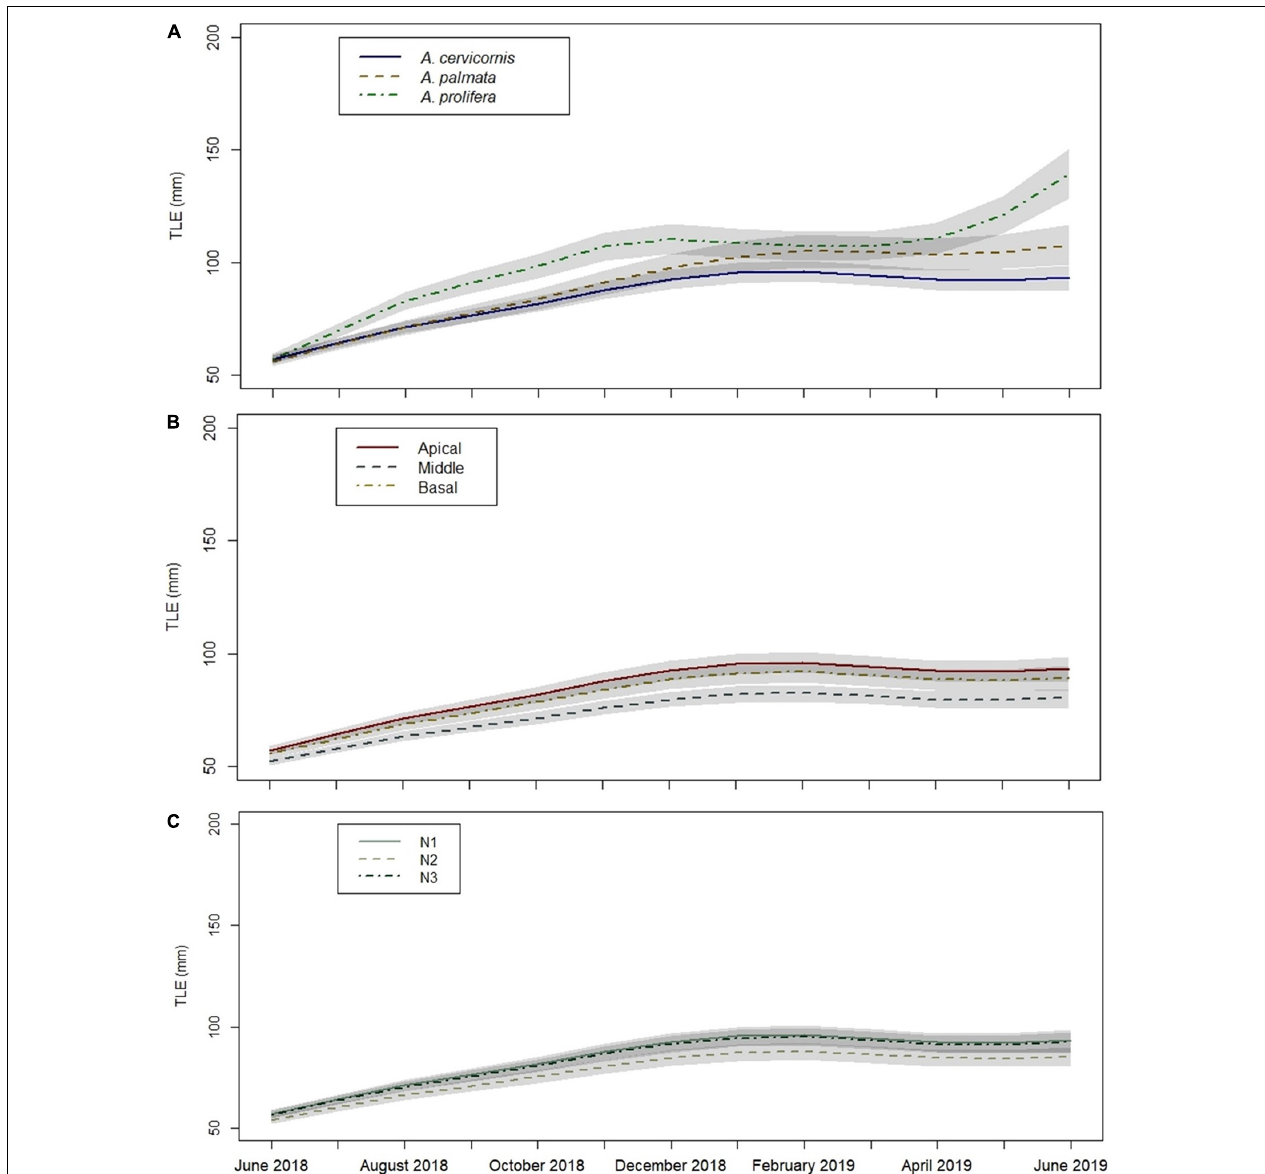
FIGURE 6 | Growth (TLE) over time based on Minimally Adequate Model (MAM) by: (A) taxa, (B) fragment section, and (C) site. Factor variables are given in each figure legend, differentiated by line type and color. Gray shaded areas denote standard error. Site N1 underlies N3 in Figure (C)